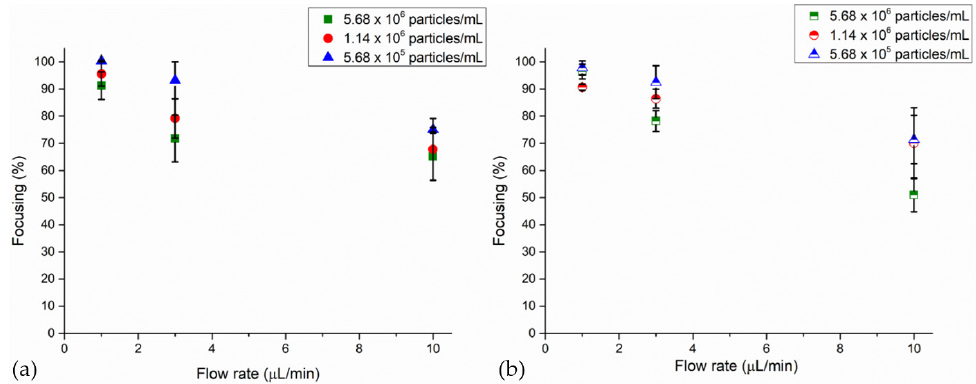
Figure 4. Focusing performance of the BAW device as a function of flow rates and 4MP concentra- tions: ( a ) UV–Vis characterization and ( b ) image analysis. Experiments were performed with 4MPs concentrated at 5.68 × 10 6 particles/mL, 1.14 × 10 6 particles/mL and 5.68 × 10 5 particles/mL. During the experiments, 4MPs were injected at 1 µL/min, 3 µL/min and 10 µL/min, while 50.59 V pp was applied at the transducer when the device was actuated at its resonant frequency of 4.623 MHz.